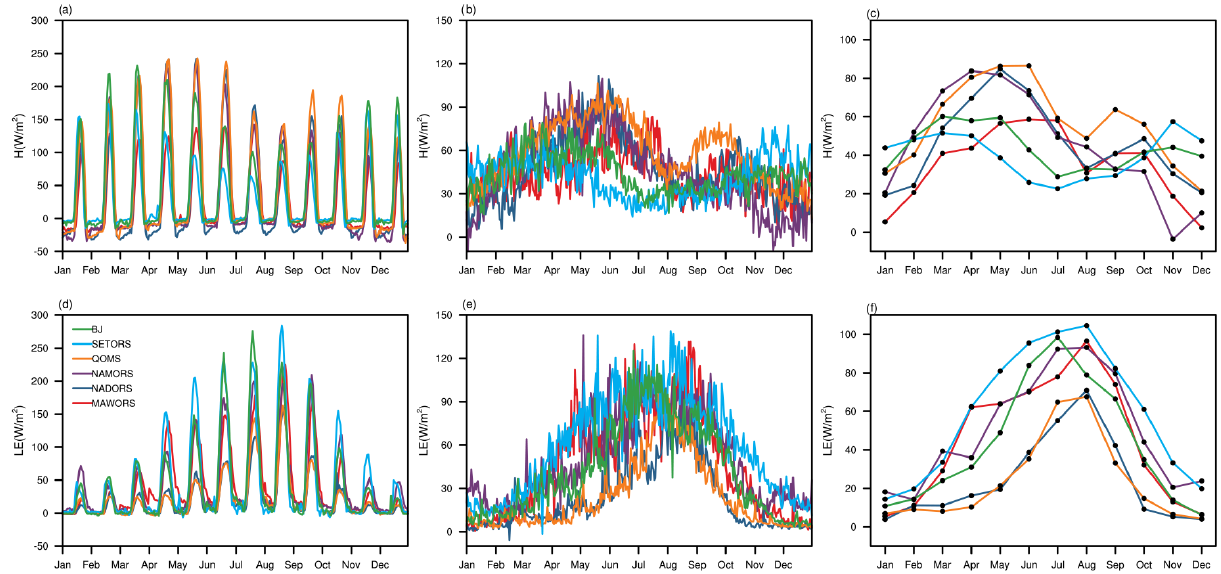
Figure 4. Same as Fig. 2, but for the climatological average of the sensible heat flux ( H ) and latent heat flux (LE)